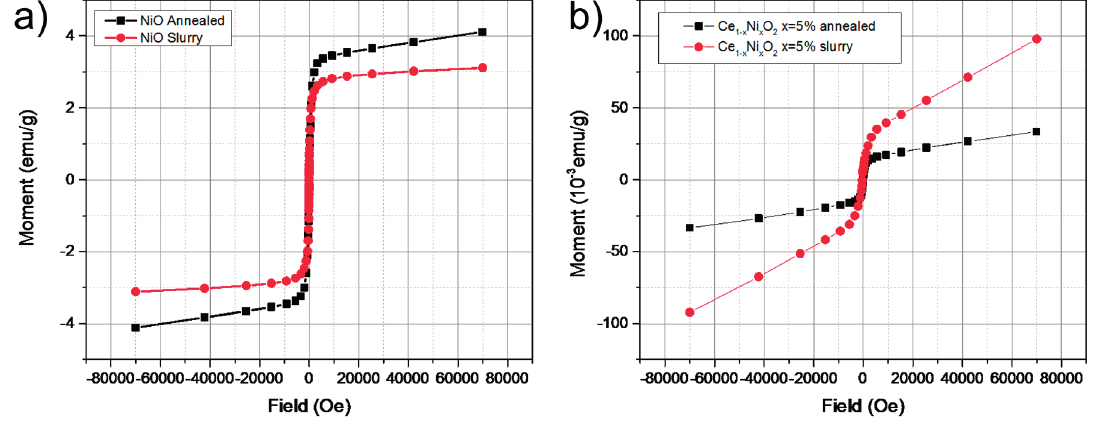
Figure 6. Magnetic hysteresis curves at 300 K for: ( a ) NiO annealed and non-annealed “slurry” samples (Sample 2) and ( b ) 5% Ni-CeO 2 (Sample 6). Magnetic saturation values were calculated by removing the high field linear component ( χ .H) from the